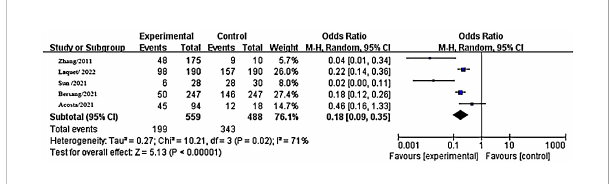
FIGURE 4 Forest plot of 5-year recurrence-free survival in two groups of patients.